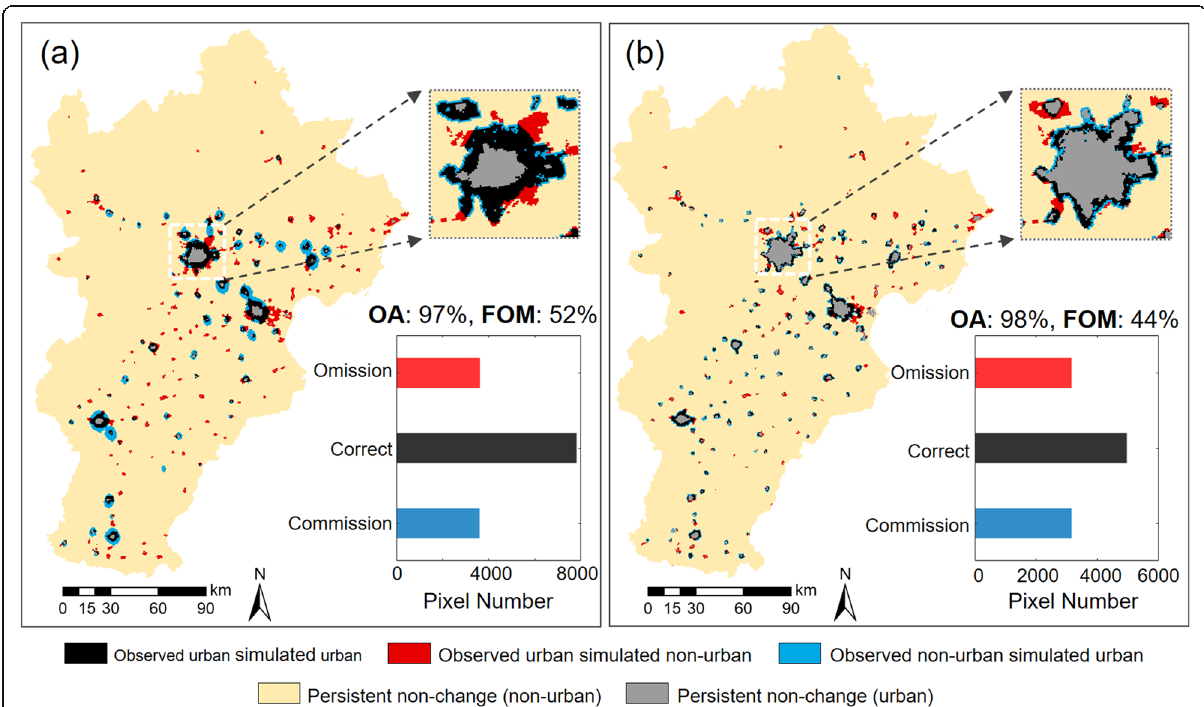
Fig. 7 Comparison of the Logistic-Trend-CA model using modeling periods of 1992 – 2013 ( a ) and 2002 – 2013 ( b ) in the Beijing-Tianjin-Hebei region at the 1-km spatial